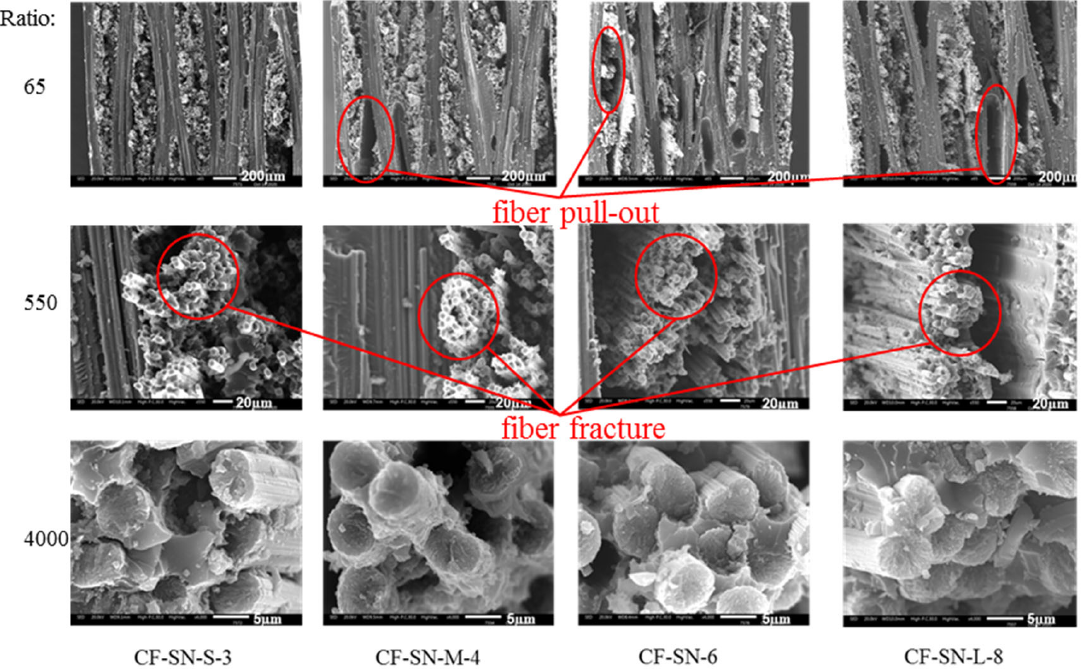
Figure 14. SEM images of the fracture position of the specimen group with an equal ratio of 𝑊 / 2 𝐶 ; no significant difference in the failure modes for the specimens of this group. Failure modes present mostly in fiber fracture and a small part of fiber pull-out and delamination, with a relatively smooth fiber fracture face.